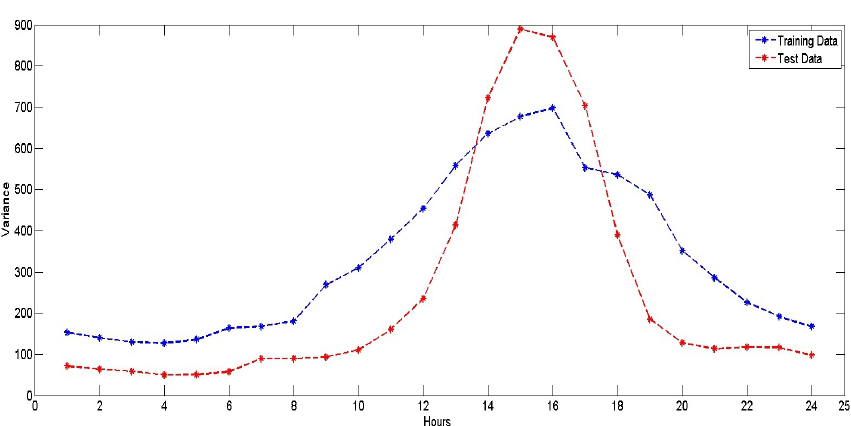
Figure 4. Hourly variance in training and testing data for NYISO (2004–2006).